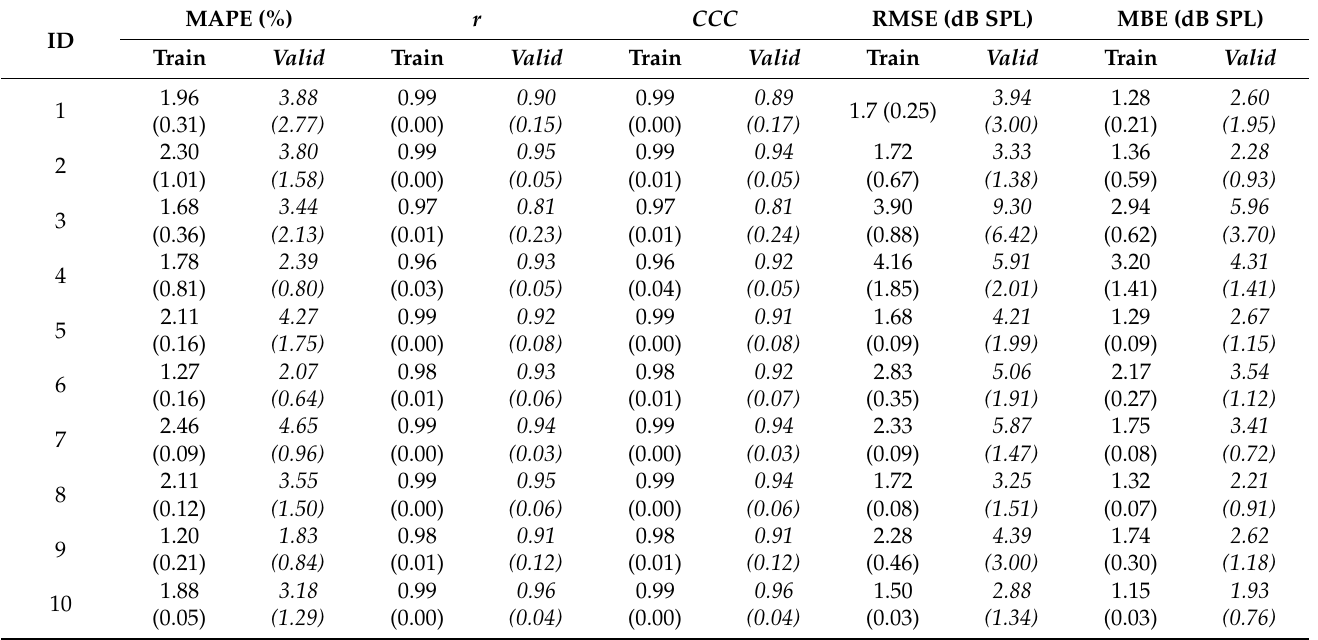
Table A3. Performance for the intensity models across k = 5 cross-validation training (Train) and validation ( Valid ) datasets for N = 10 participants. Results are shown as mean (standard